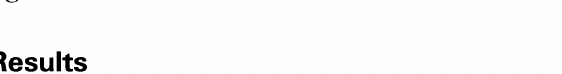
immunoassay. 16 normal. No infiltration of inflammatory cells was